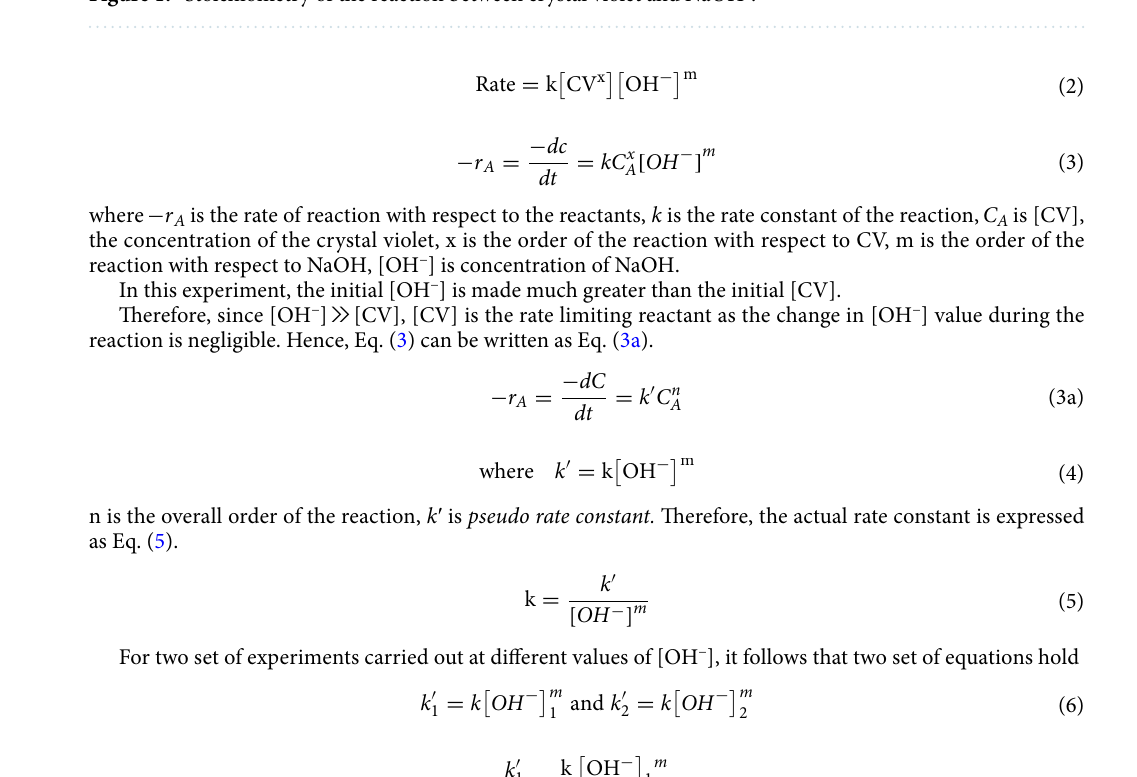
Figure 1. Stoichiometry of the reaction between crystal violet and NaOH 1